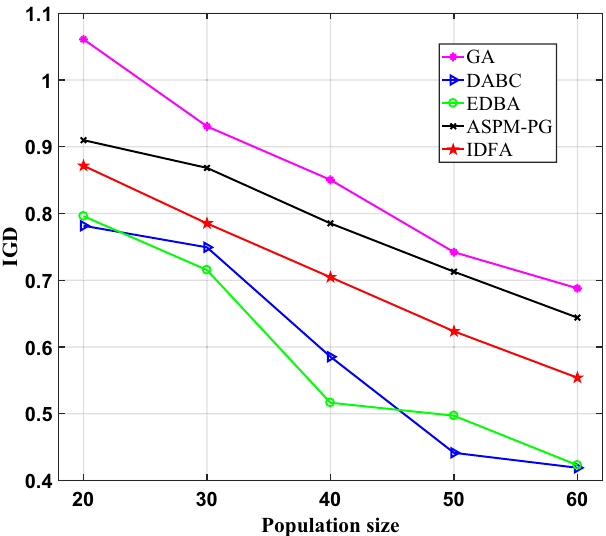
Figure 13. IGD of five algorithms in different populations.